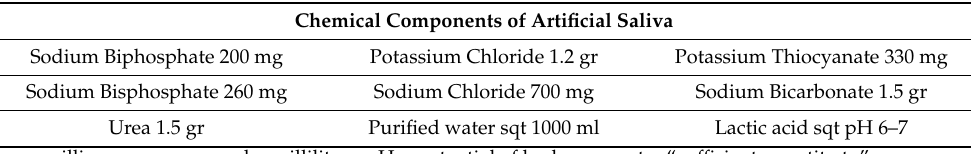
Table 1. Composition of the artificial saliva used to conduct the